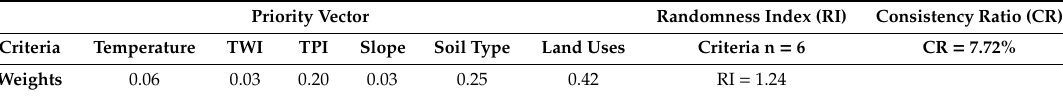
Table 2. Relative weights of the criteria, randomness index (RI), and consistency ratio (CR), resulting from the